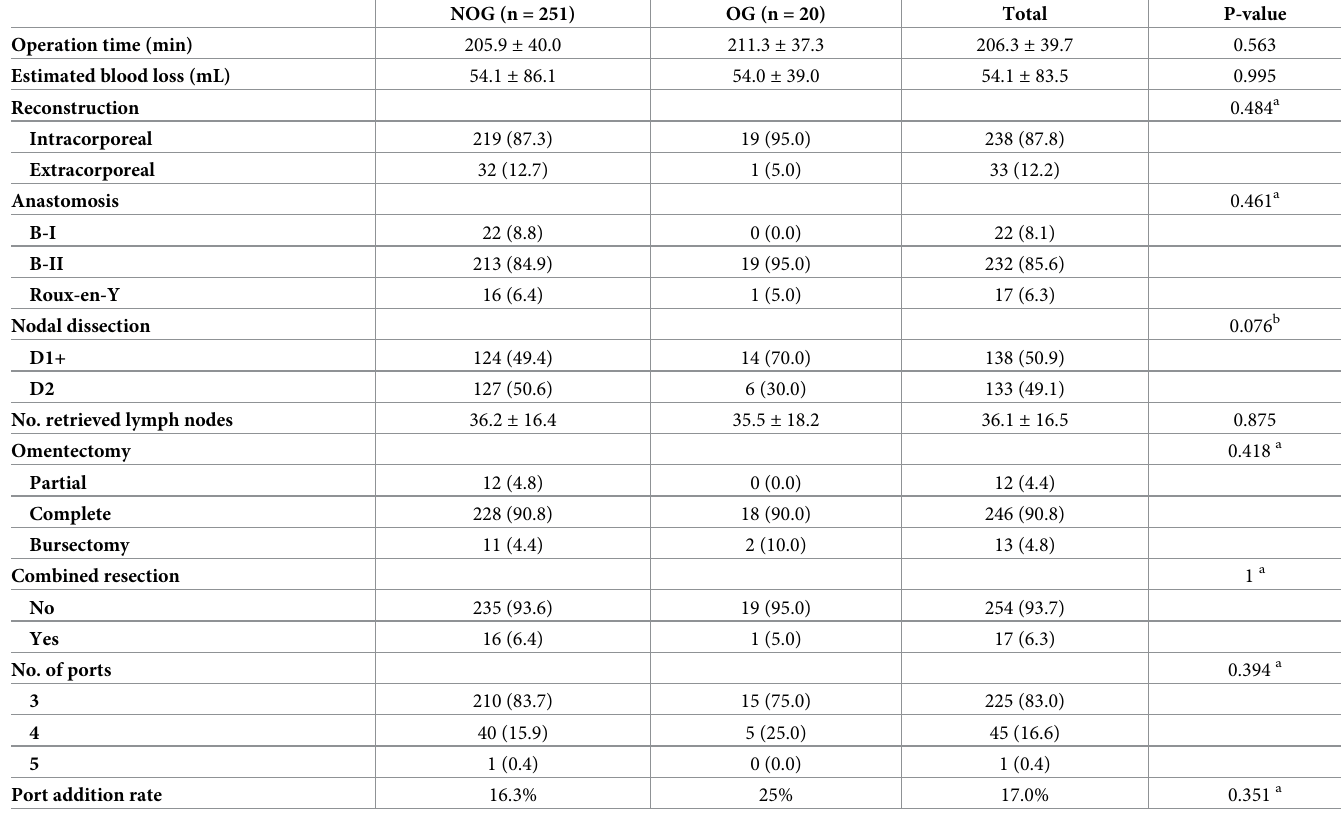
Table 2. Operative